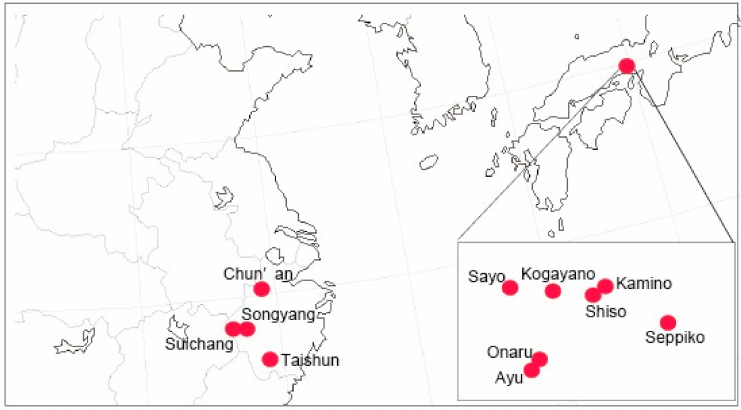
Figure 7. The study sites of M. montis-koyae